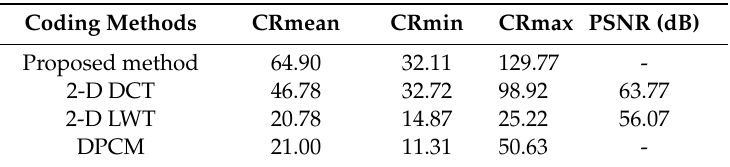
Figure 11. Comparison of the compression ratio of the signal compression by LZW. Table 2. Comparison of the compression ratio of the methods proposed in this paper with 2-D DCT, 2-D LWT, and DPCM.